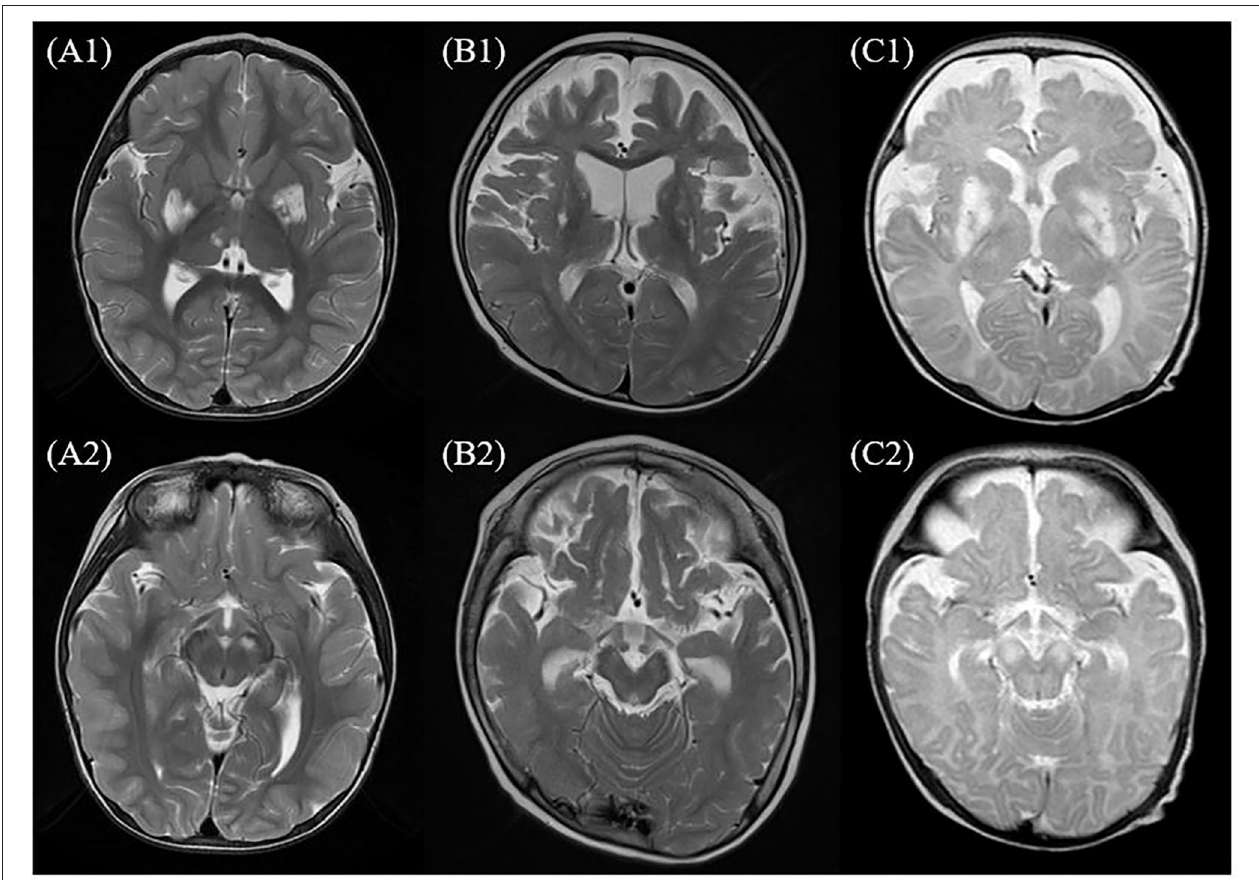
FIGURE 1 | MRI of the brain findings in the patients with Leigh syndrome with MT-ND3 mutation. This figure shows some findings from T2-weighted axial images of MRI of the brain in the patients with Leigh syndrome with MT-ND3 mutation. (A1,A2) Hyperintense signal abnormalities are observed in both the basal ganglia, brainstem, and thalamus (patient 7). (B1,B2) Hyperintense signal abnormalities in both the basal ganglia and diffuse brain atrophy prominently at bilateral frontotemporal lobes with secondary ventricular dilatation are observed (patient 2). (C1,C2) Diffuse abnormal signal changes at both the basal ganglia, thalami, and brainstem are observed and diffuse brain atrophy is also observed (patient